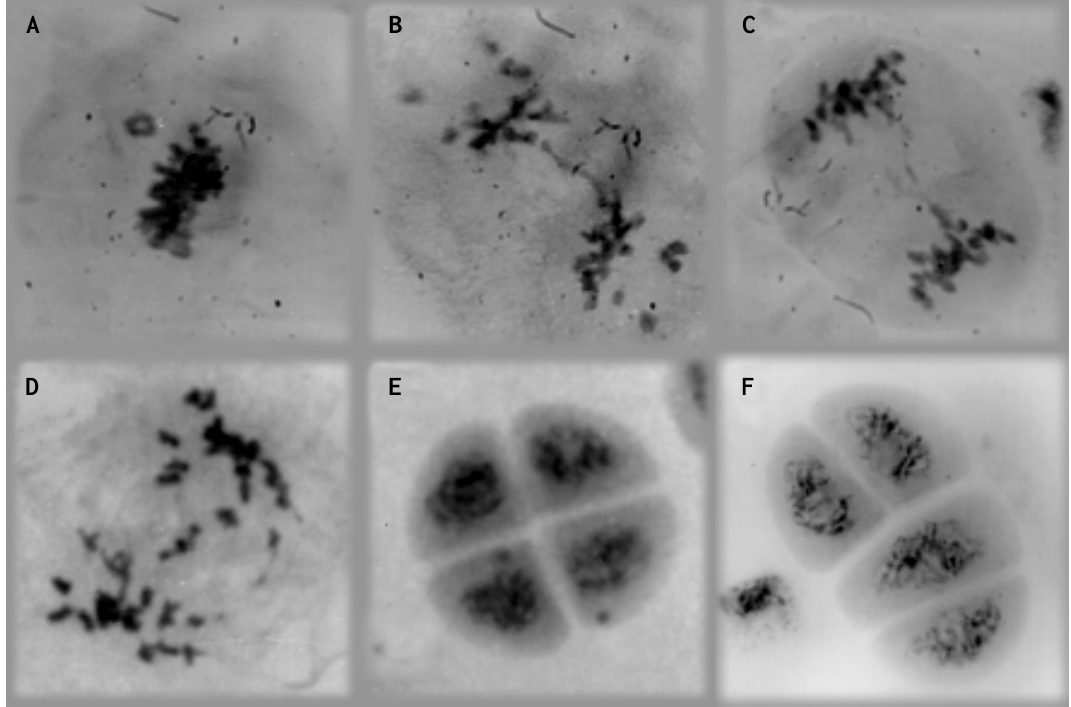
Figure 10 - Cytologic abnormalities in oat somaclones. A ) Metaphase I with one chromosome out of the plaque. B , C and D ) Anaphase I showing bridges, chromosome fragments and late chromosomes. E ) Pollen tetrad with micronucleus. F ) Pollen tetrad with abnormal orientation called